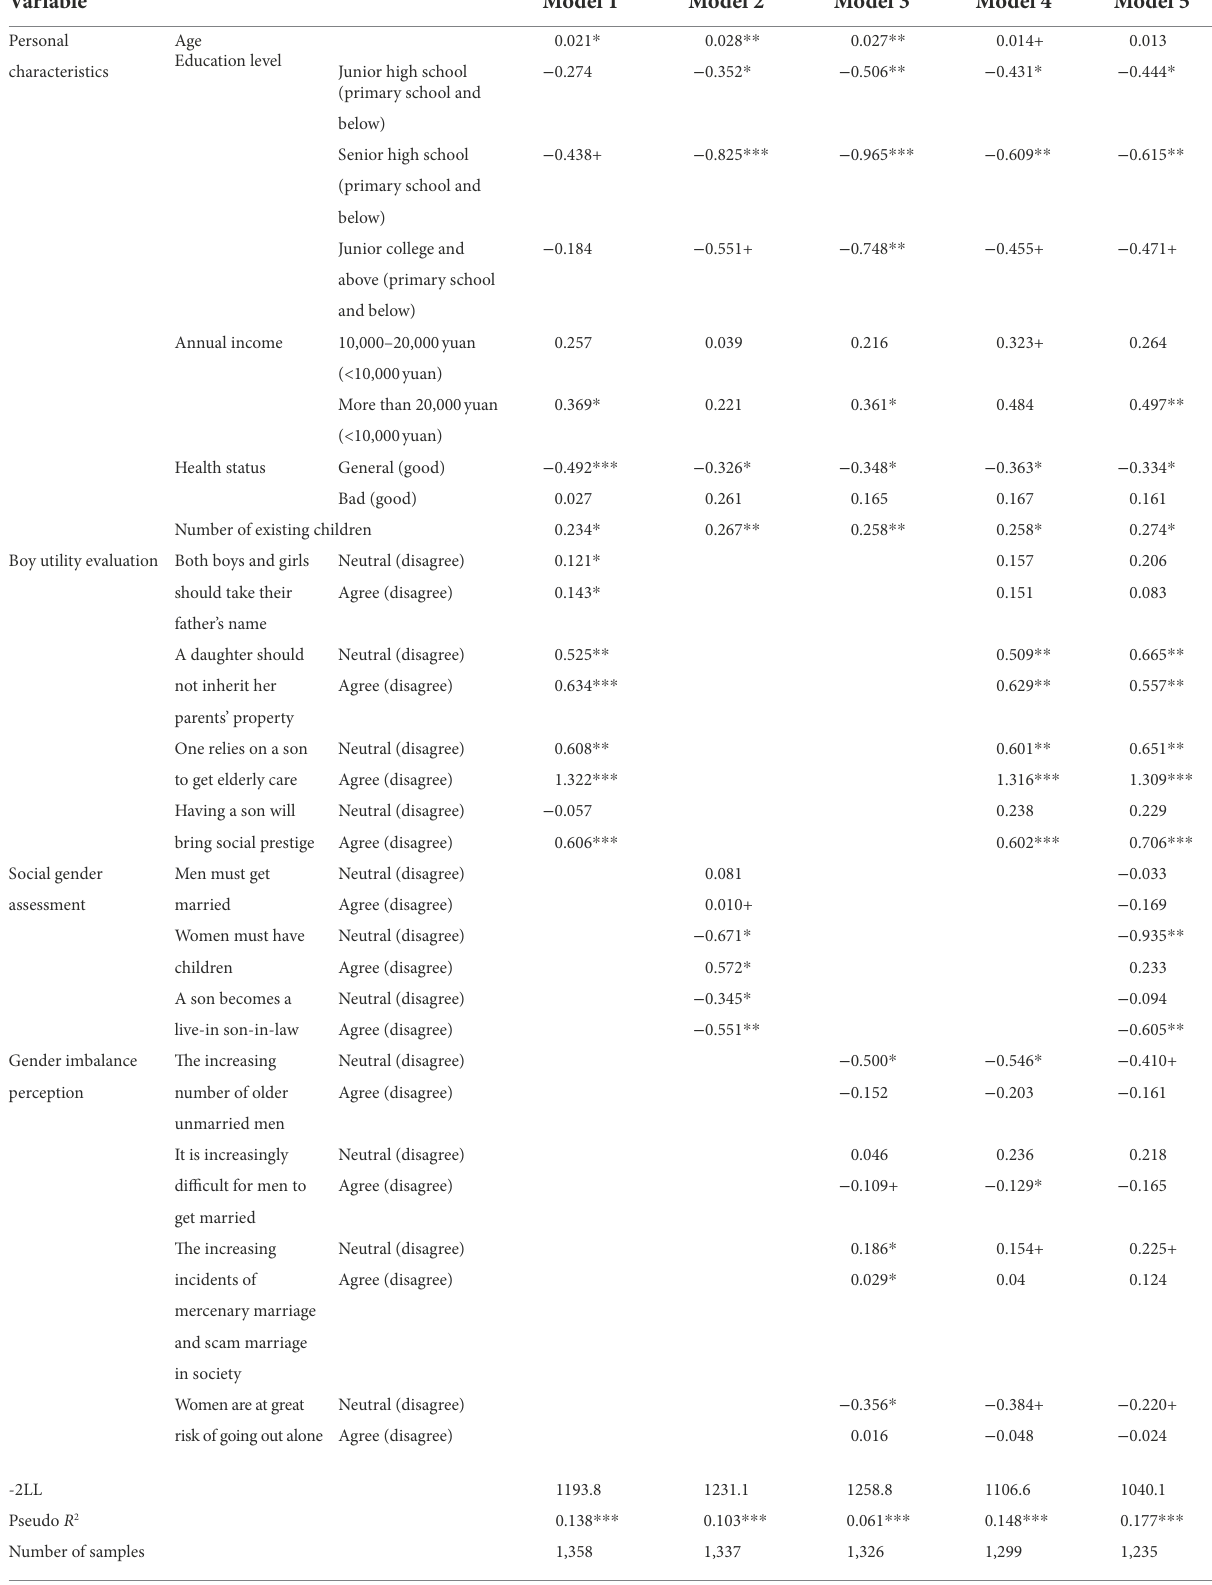
TABLE 3 Logistic model results for son